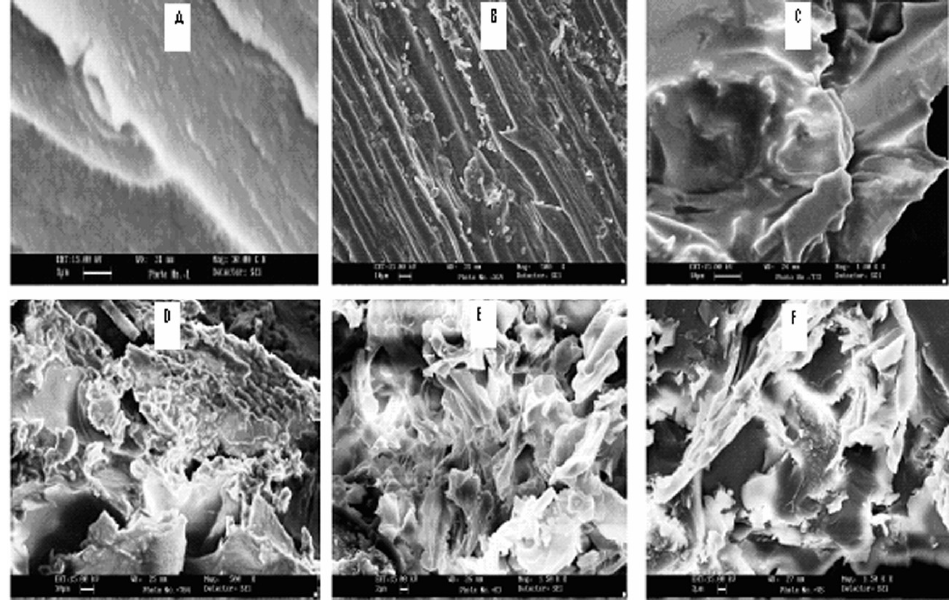
Figure 2. SEM images of (A) UF resin (B) Saccaharum Cilliare fiber (C, D, E& F) composite with 10, 20, 30 & 40% loadings. Table 1. Thermo-gravimetric analysis of UF, SC and SF-Rnf UF